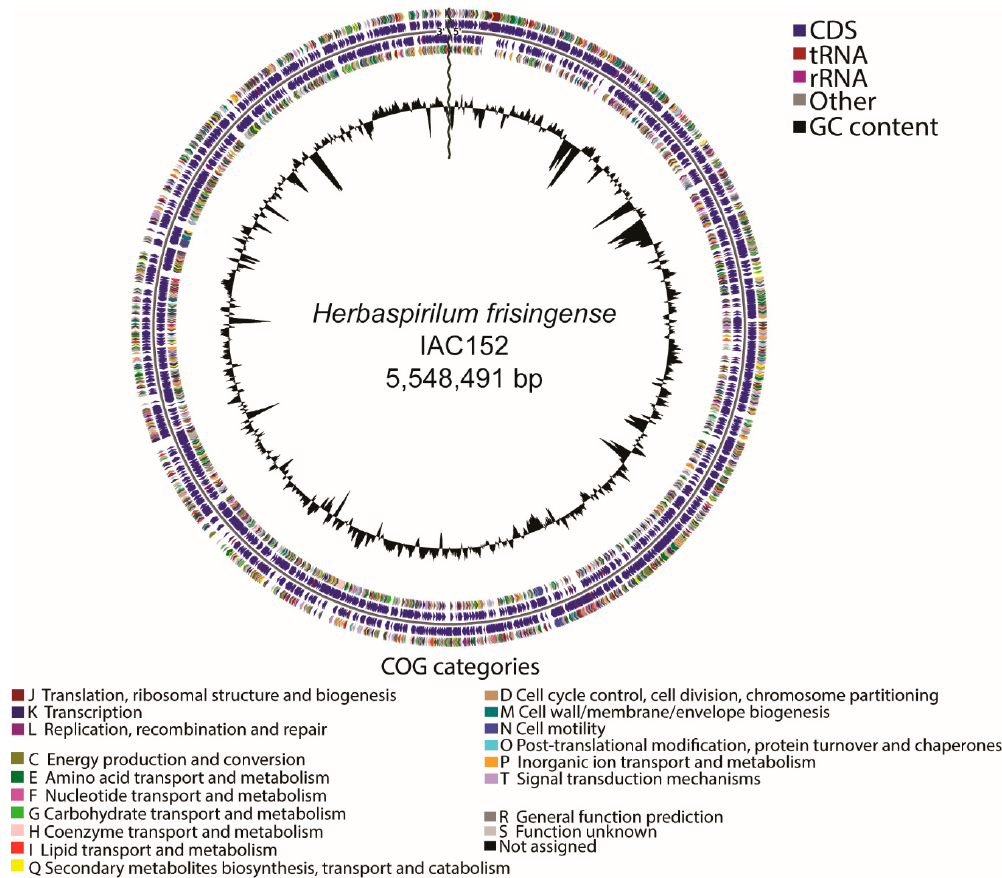
Figure 4. Graphical circular genome map of Herbaspirillum frisingense strain IAC/BECa 152. The rings indicate coding sequences, Clusters of Orthologous Groups of proteins (COGs) categories, GC content, and GC skew. Microorganisms 2020 , 8 , x FOR PEER REVIEW 11 of 22